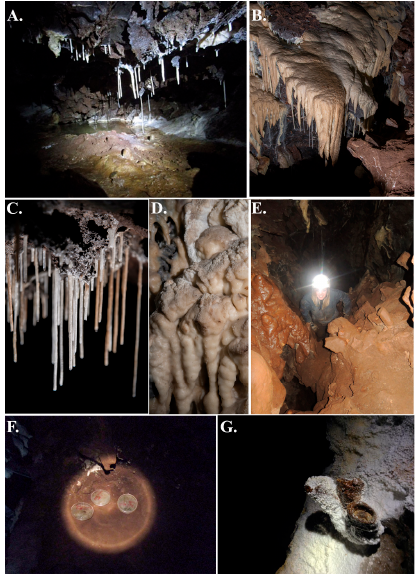
Figure 2. Iron Curtain Cave, Chilliwack, British Columbia, Canada. ( A ) Site #4: The Octopus Room;